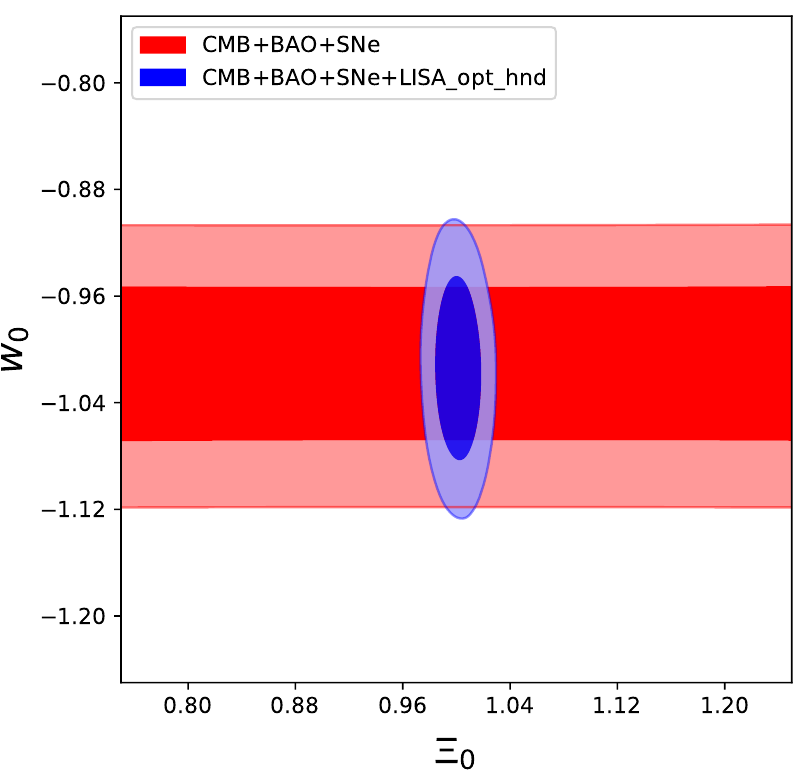
Figure 9. Constraints on w 0 , parameterizing a constant DE equation of state, and Ξ 0 obtained using CMB+BAO+SN (red) and when adding LISA forecast data to the previous combination (blue). This figure is taken from [133], where also different cases for the noise and for the seeds of the binaries have been investigated, and reproduced by permission of IOP Publishing. All rights